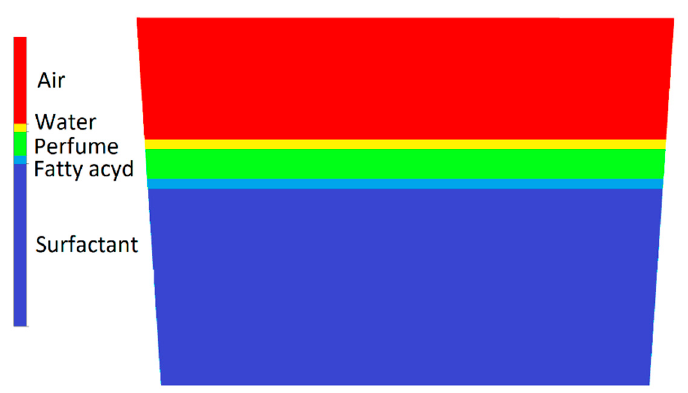
Figure 3. Image of a vertical section by canister axis of the canister initial compounds filling condition. Surfactant in red; fatty acid in yellow; perfume in green; water in light blue; and the air above the liquid’s surface in dark blue.